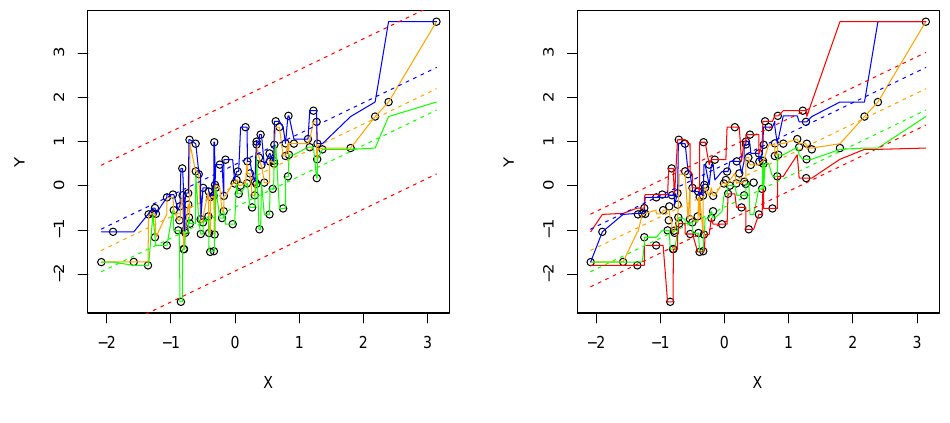
Figure 11: BBP in option 3 for the data in Example 2.1 estimated with the three-points (left) and the seven-points (right) meth- ods. The dashed lines represent the theoretical BBP. The orange lines represent the median curves, the blue lines, the third quartile curves, and the green lines, the first quartile curves. The red lines in the right plot can be used to get the